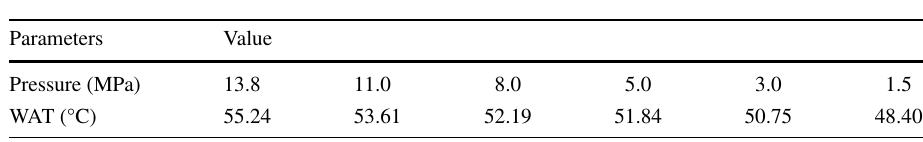
Fig. 1 Dependence of the wax appearance temperature on